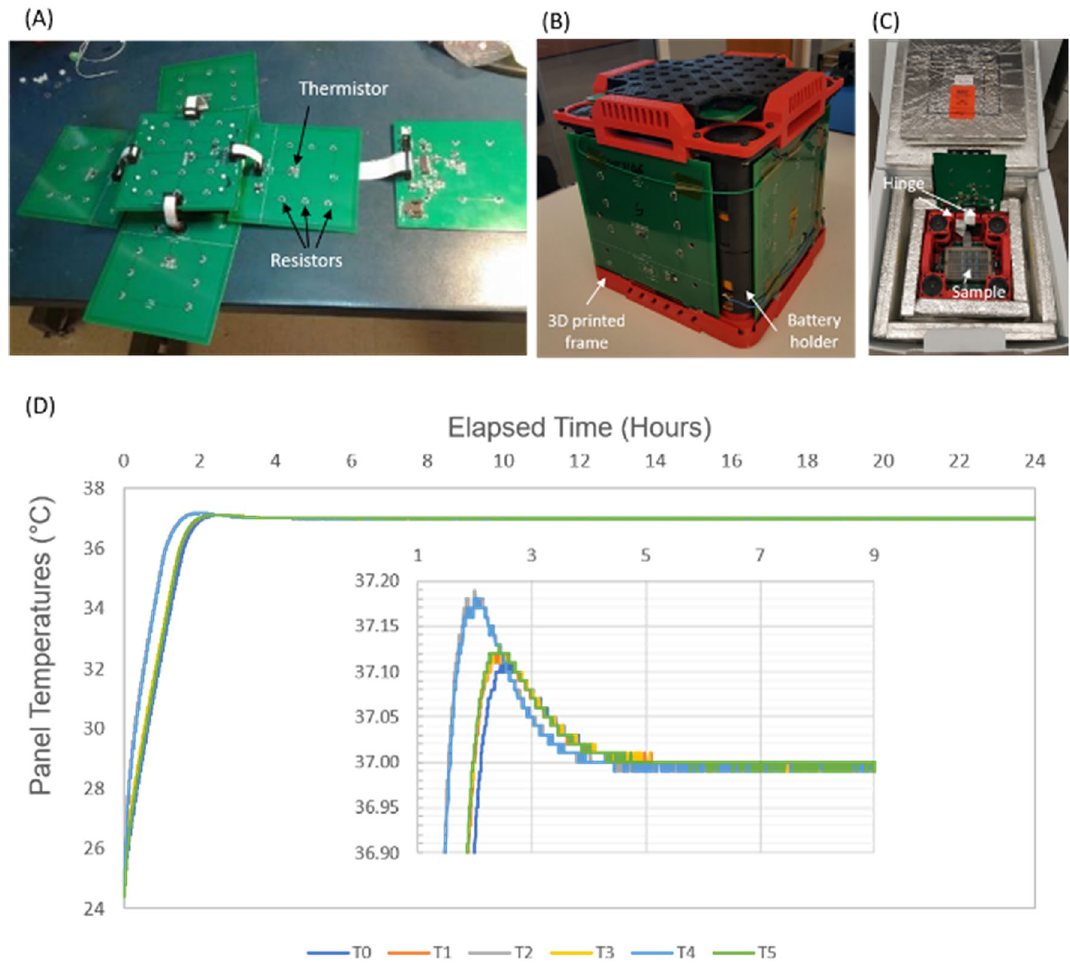
Figure 2. ( A ) Six PCBs connected by ribbon cables that are used to form the temperature-controlled isothermal internal surfaces of a µCRAIT box. Each PCB temperature is controlled by resistive heating of six resistors and microcontroller feedback of a thermistor; ( B ) a 3D-printed frame that holds the six PCBs, as well as 4 battery holders at the corners; ( C ) a µCRAIT box by housing the 3D-printed PCB frame box inside a traditional dual- wall VIP insulated shipping box; ( D ) typical temperature curves of the six PCB panels heated towards 37 °C from room